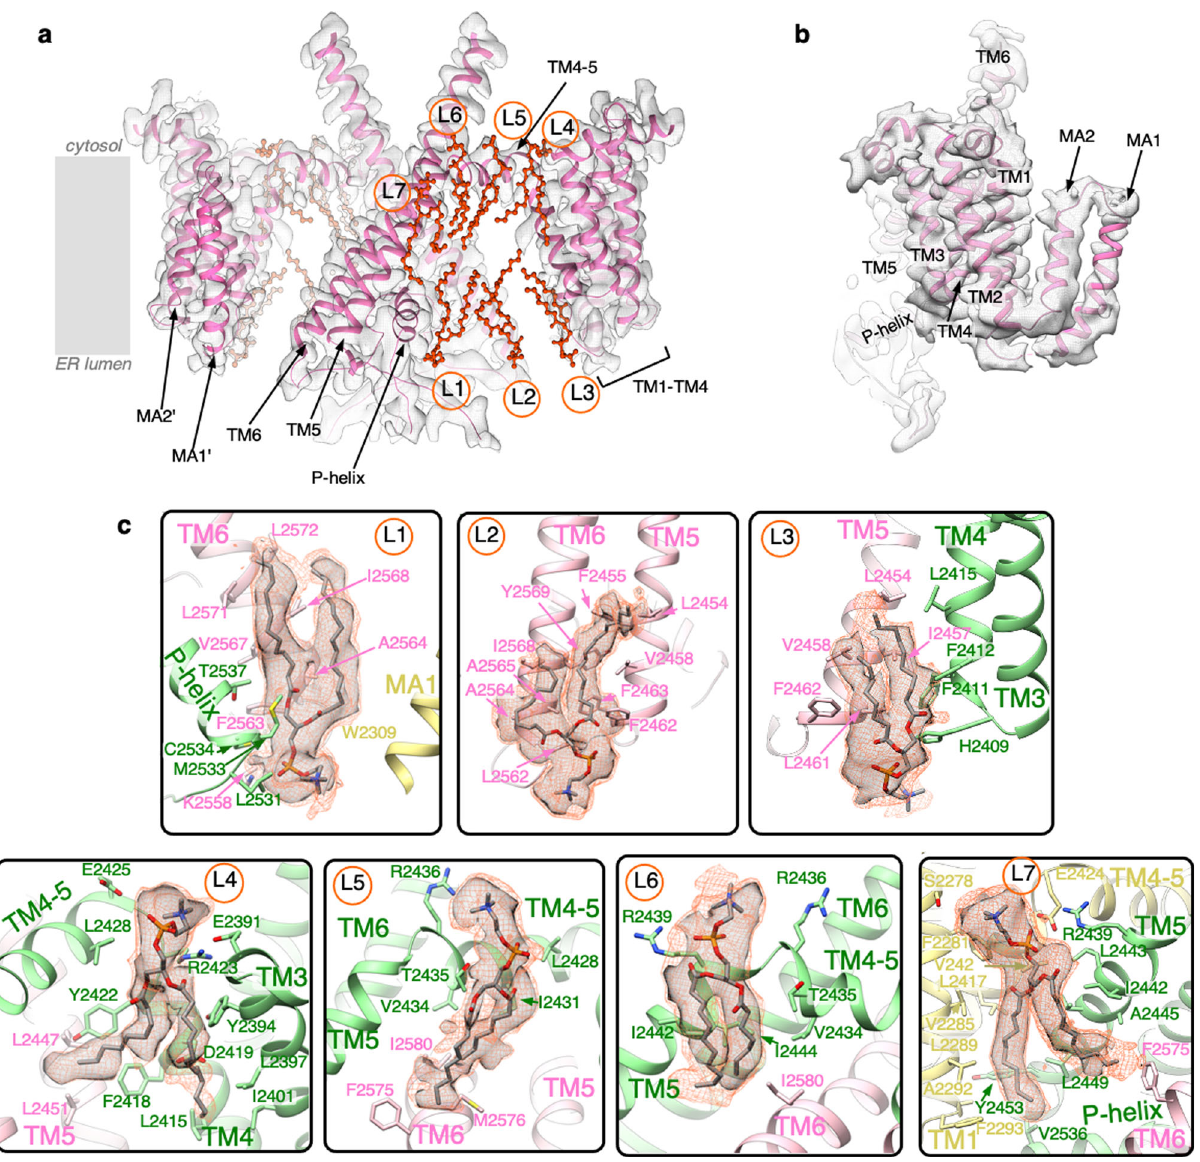
Fig. 3 Protein – lipid interactions identi fi ed in IP 3 R1-ND structure. a IP 3 R1-ND cryo-EM density map for TM1 – TM6 helices of two opposing subunits; the model is depicted as a ribbon and viewed parallel to the membrane plane. Lipids are represented as orange ball-and-stick models and labeled L1 – L7. b TMD densities for one subunit are overlaid with the IP 3 R1-ND model viewed parallel to the membrane plane and rotated ~90° from the position in a . c Zoomed-in views of seven lipid-binding sites (L1 – L7) identi fi ed in the TM region. Lipids are putatively modeled as phosphatidylcholine (see “ Methods ” section); the PC models are colored by elements and fi t into corresponding cryo-EM densities displayed at 3 – 5 σ cut-off values (gray) and 2 – 2.5 σ (orange mesh). TM helices are depicted as ribbons colored by channel subunit. Residues within 5 Å of the lipid molecules are displayed in a stick representation and permeation pathway of IP 3 R1 (Fig. 3a, c). One lipid molecule (L1) is found at a junction between three IP 3 R1 subunits: the central pore-lining TM6 and P-helix of two neighboring subunits and the MA helices from another subunit (Fig. 3c). The intra-subunit binding site for L2 is formed by the hydrophobic and aromatic TM6 and the other acyl chain intercalating between the lumenal ends of TM5 and TM6 (Fig. 3c). L3 fi lls the lumenal crevice between the TM4 and TM5 helices of two neighboring subunits.